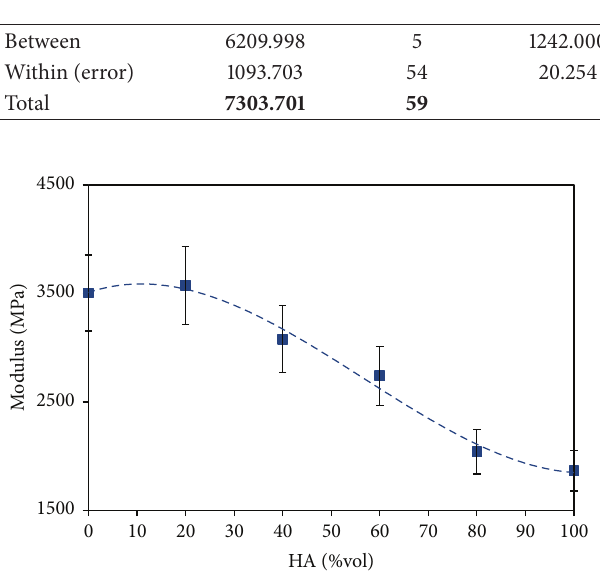
Figure 4: Failure strength and Young’s modulus values at increasing HA/Silica filler ratio. Errors bars are standard